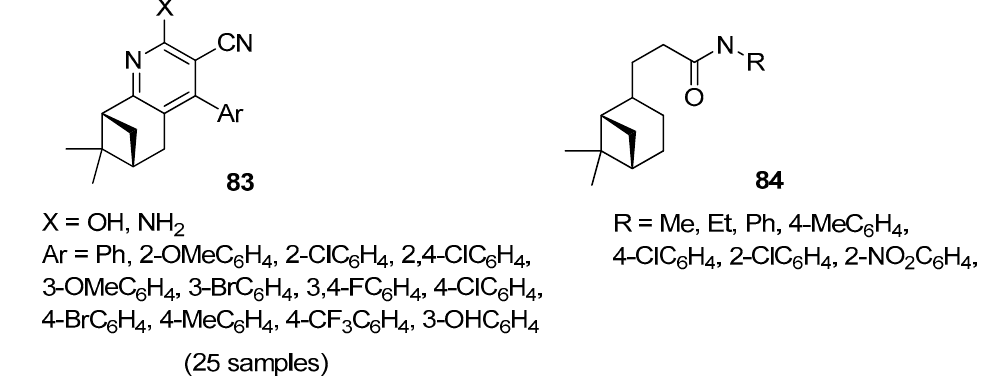
Figure 19. (–)- β -Pinene derivatives with antimicrobial and insecticidal activities.